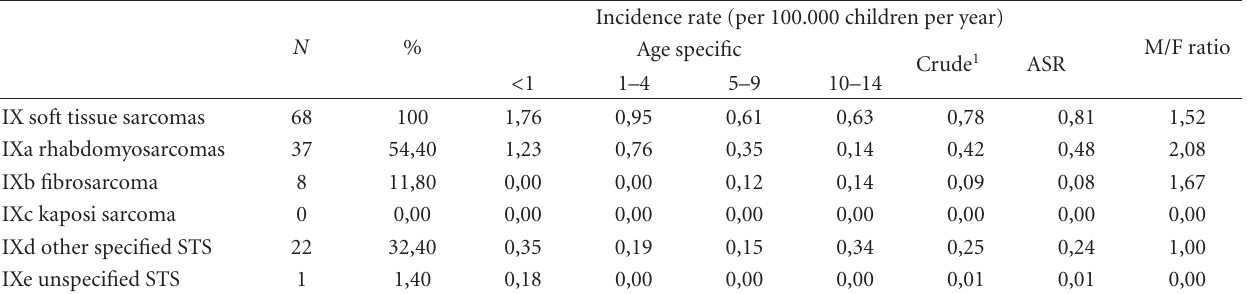
Table 2: Absolute number of cases, crude, ASR, and age-specific incidence rate of soft tissue sarcomas by ICCC-3 in children (0–14 years) diagnosed in Moscow Region in 2000–2009.